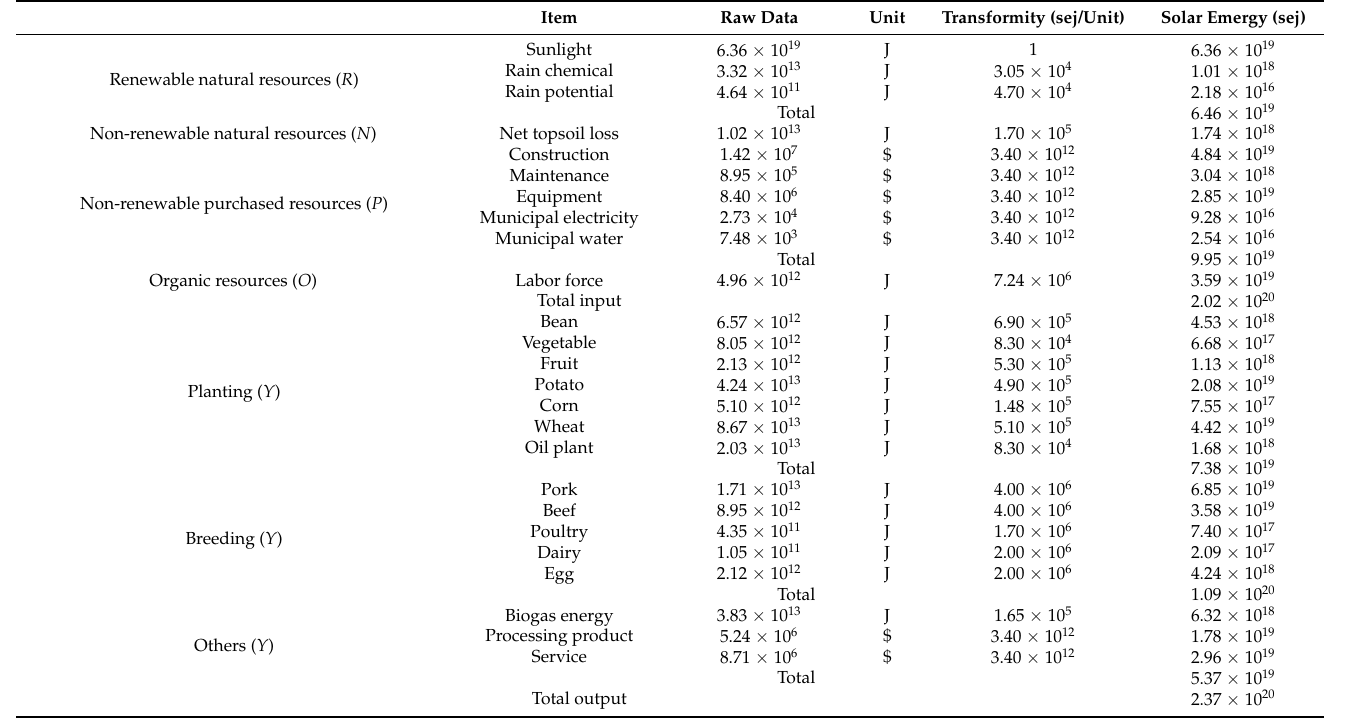
Table 6. Emergy input and output of the village